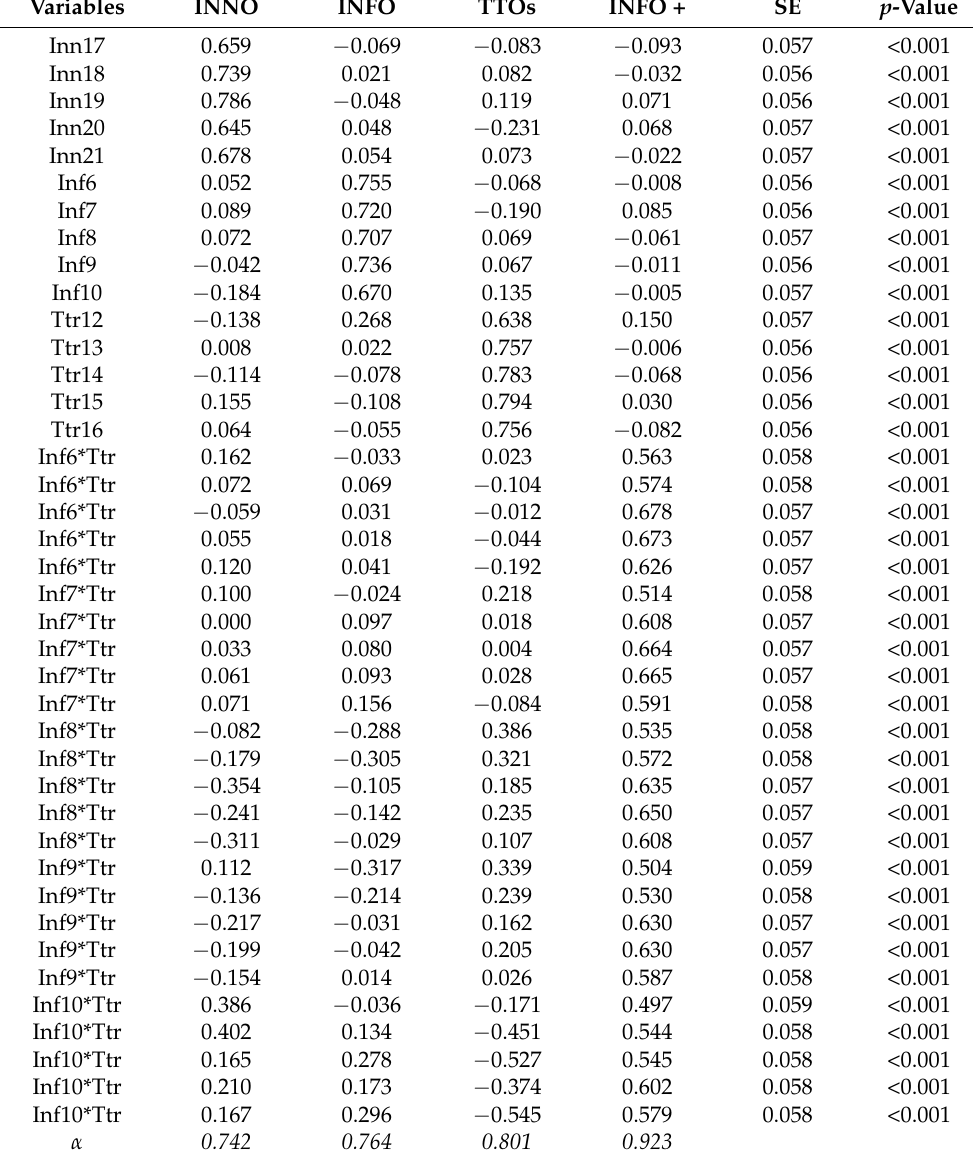
Table 2. Combined loadings of the measurement models. Source: Author